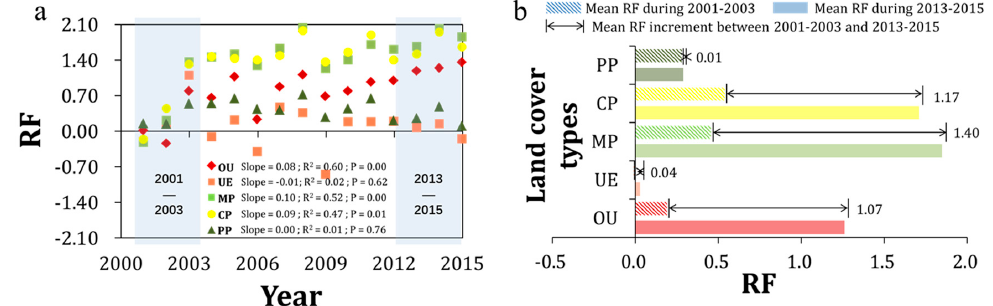
Figure 11. Annual dynamics of radiative forcing (RF) from 2000 to 2015 ( a ) and RF increment between 2001–2003 and 2013–2015 ( b ) of various land cover types in